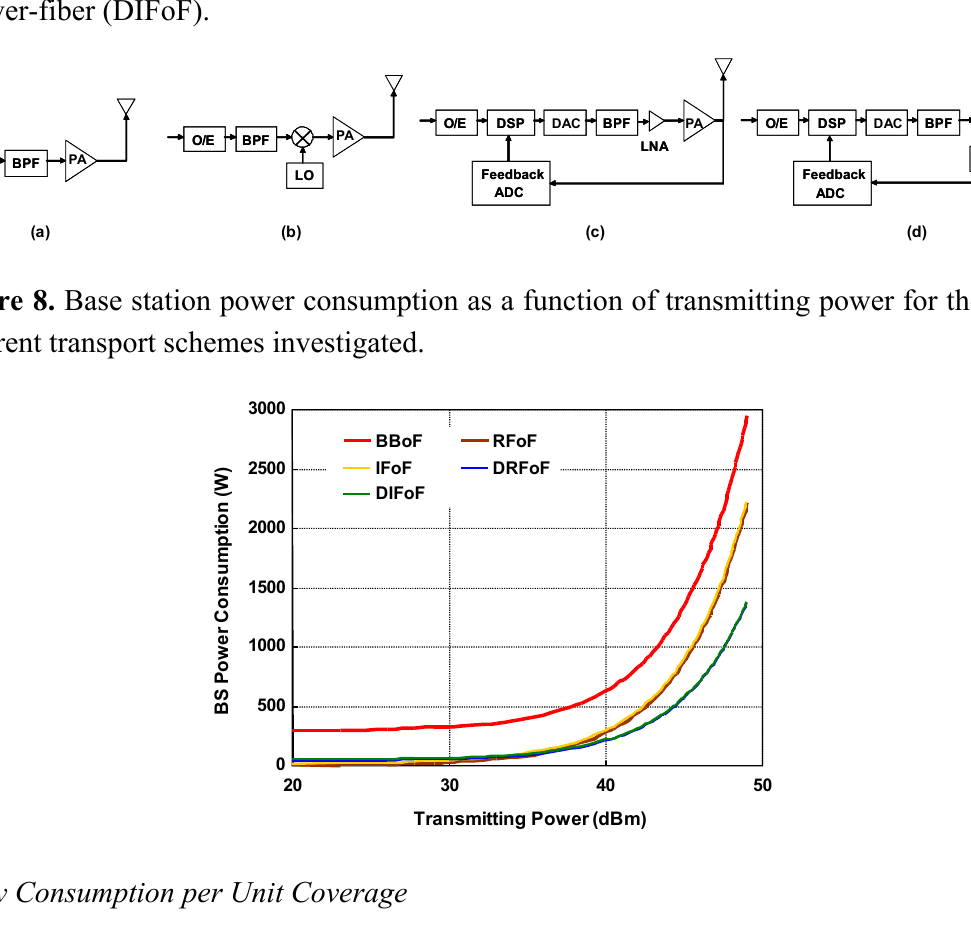
Figure 7. Base station architectures for ( a ) Analog RF-over-fiber (RFoF) ( b ) Analog IF-over-fiber IF-over-fiber (DIFoF).